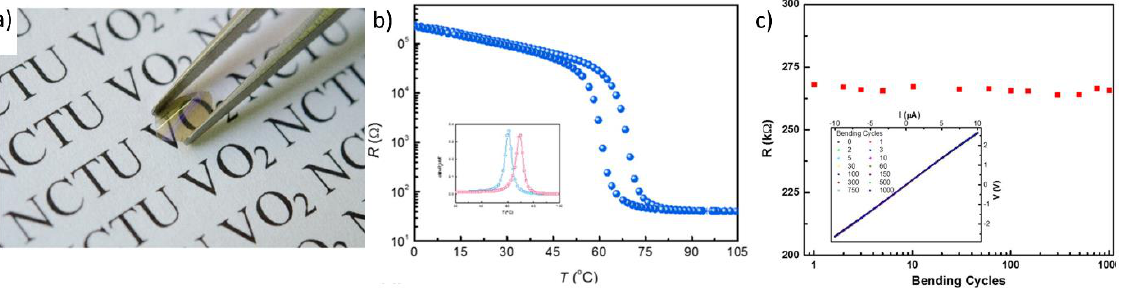
Figure 2. ( a ) Photograph of VO 2 /muscovite thin film; ( b ) Temperature-dependent electrical resistance of VO 2 /muscovite films; ( c ) Cyclability of VO 2 /muscovite films over 1000 iterations in a bending test. Reproduced with permission from [86]. Copyright 2016, American Chemical Society.